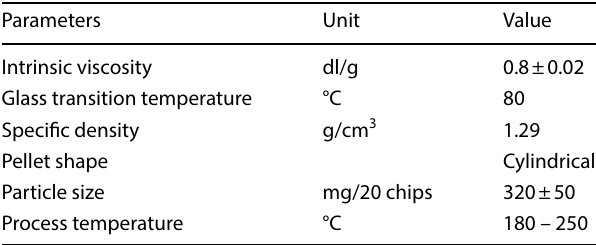
Table 2 Material characteristics of the granulate Mimesis DP 300 [23]